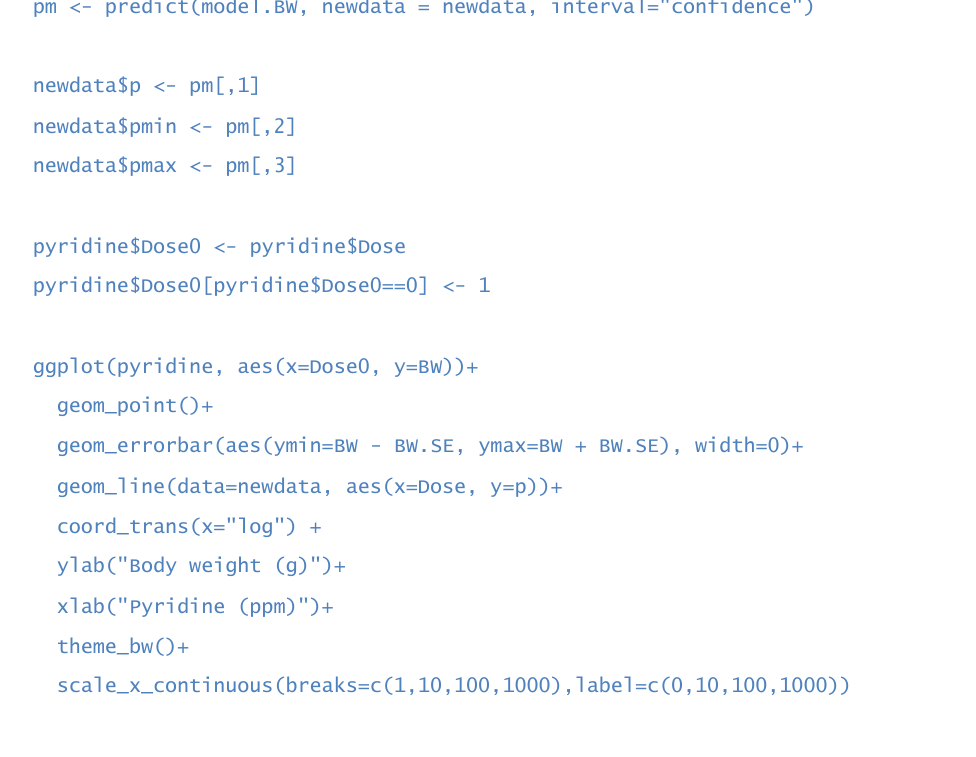
Dose-response analysis continuous summary data